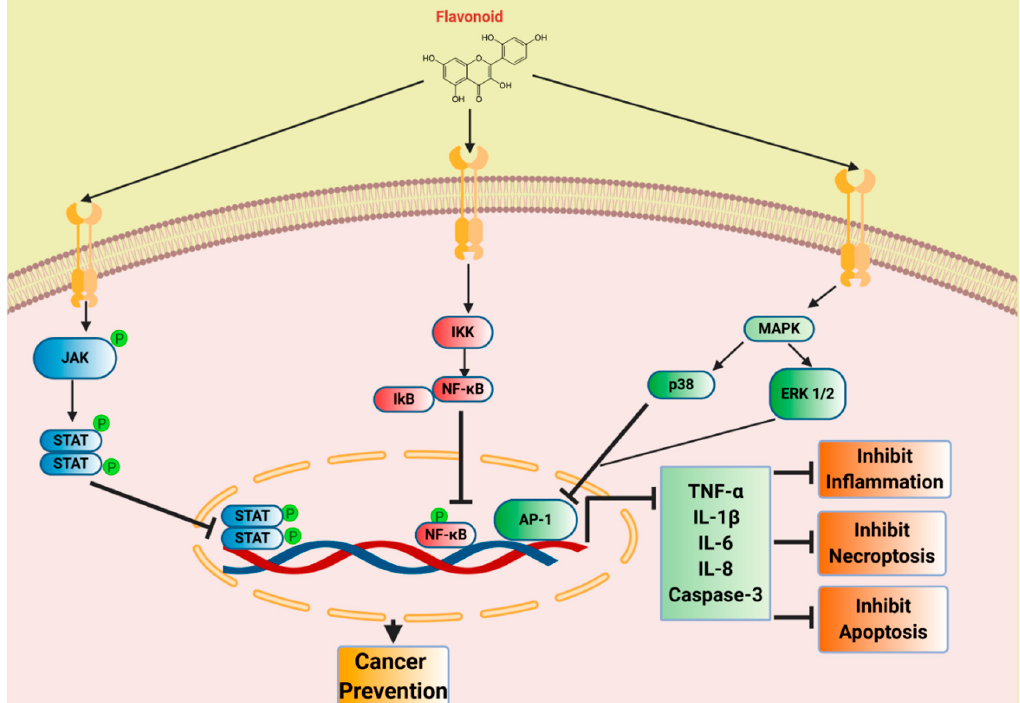
Figure 4. Flavonoids inhibiting inflammatory and cancer markers: The flavonoids can modulate several receptors and their corresponding signaling cascades. The flavonoids exert its effects mainly through JAK/STAT, IKK/NF- κ B, and MAPK pathways leading to inhibition of pro-inflammatory, pro-apoptotic, and pro-necroptosis markers. The effector molecules that are downregulated include cytokines and cell death markers such as IL-1 β , TNF- α , IL-6, IL-8, caspase-3, etc. These cellular events ultimately lead to immune regulation and cancer prevention.